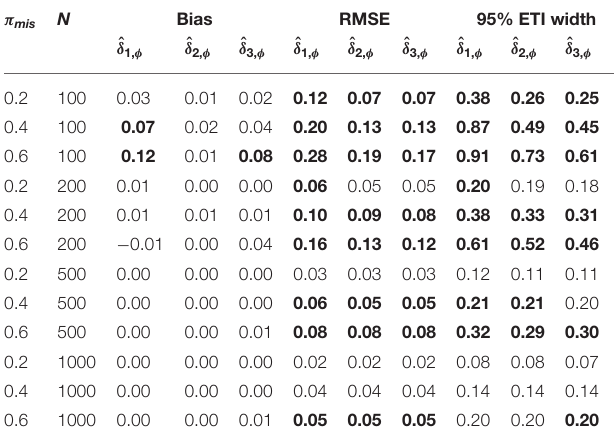
TABLE 4 | The bias, RMSE, and the 95% equal-tailed interval width of factor correlation FMIs under linear MAR.